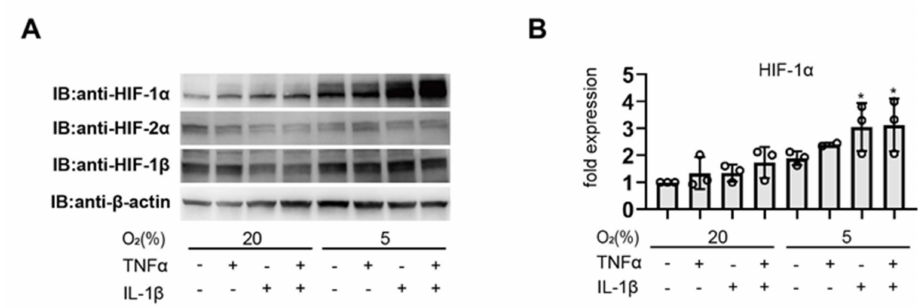
Figure 2. Inflammatory cytokines and hypoxia synergistically increase HIF-1 α protein accumulation. ( A , B ) Representative immunoblots. EM-E6/E7/TERT cells were exposed to culture media (–), TNF α (500 ng/mL), and IL-1 β (100 ng/mL) under 20% or 5% O 2 conditions for 6 h. Whole-cell lysates were immunoblotted for HIF-1 α , HIF-2 α , HIF-1 β , and β -actin following treatment. There were at least three such experiments carried out. (B) Densitometric analysis results that have been β -actin-